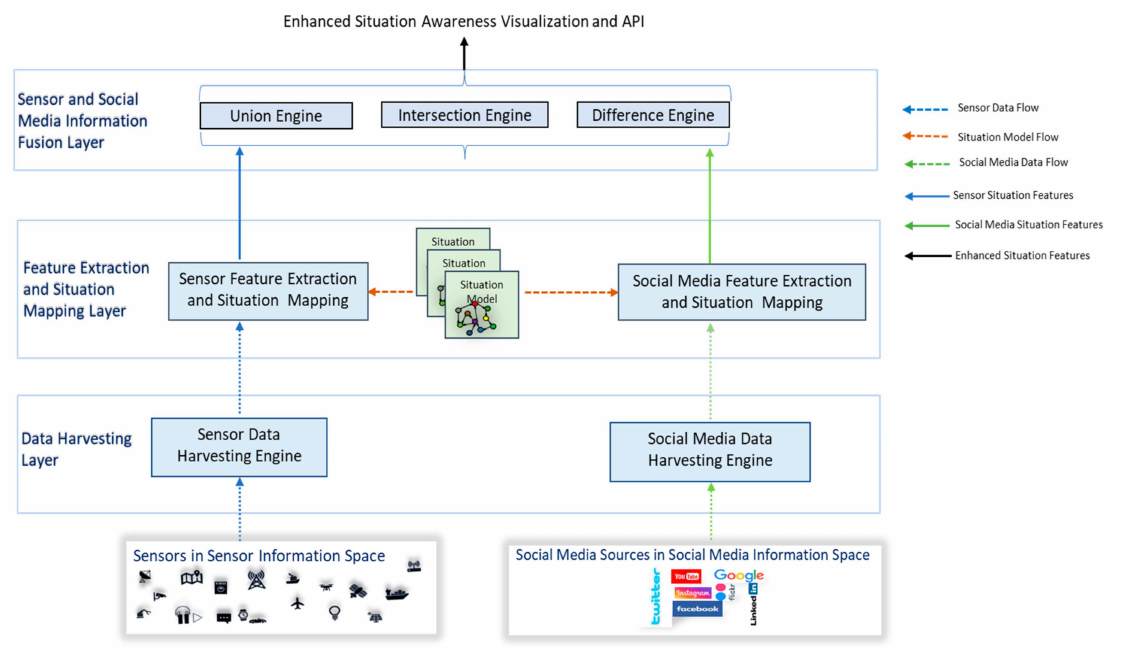
Figure 2. Architecture of CPSA platform for improving situation awareness using sensor and social media information spaces based on a situation